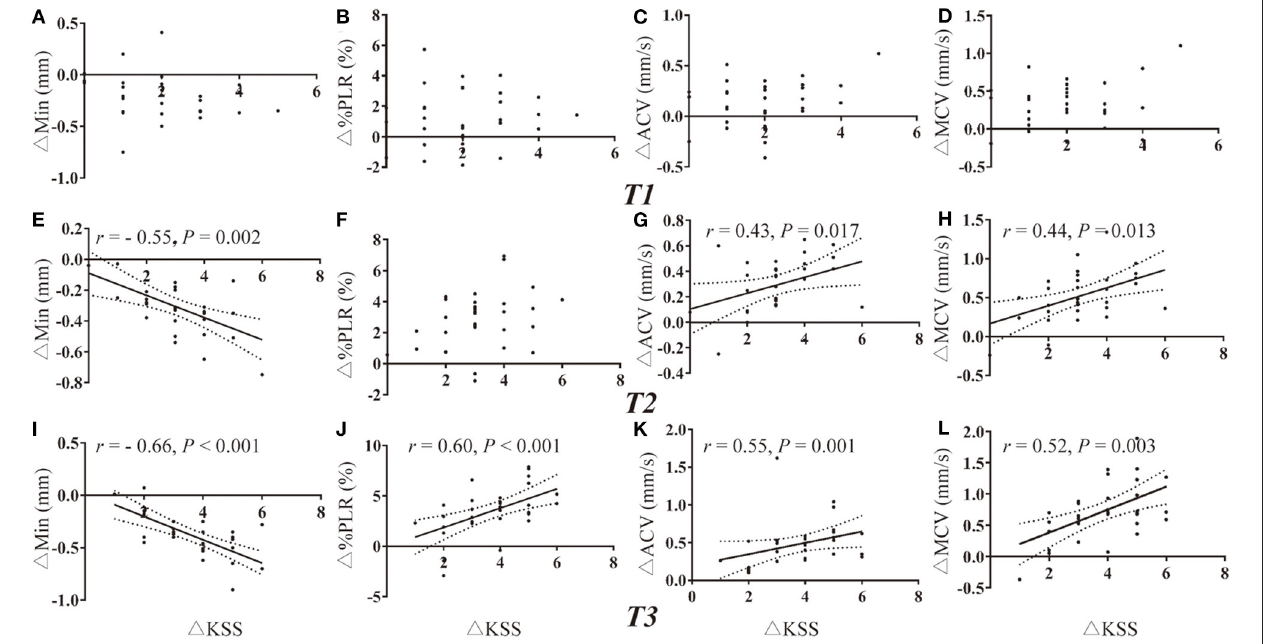
FIGURE 3 | Correlations of PLR variations with the change in KSS. (A–D) Correlation of 1 KSS with the change in PLR parameters at T1. (E–H) Correlation of 1 KSS with the change in PLR parameters at T2. (I–L) Correlation of 1 KSS with the change in PLR parameters at T3. ACV, average constriction velocity; KSS, Karolinska Sleepiness Scale; MCV, maximum constriction velocity; Min, minimum pupil size; %PLR, constriction percentage; 1 , differences in all variables from baseline to the measurement at each